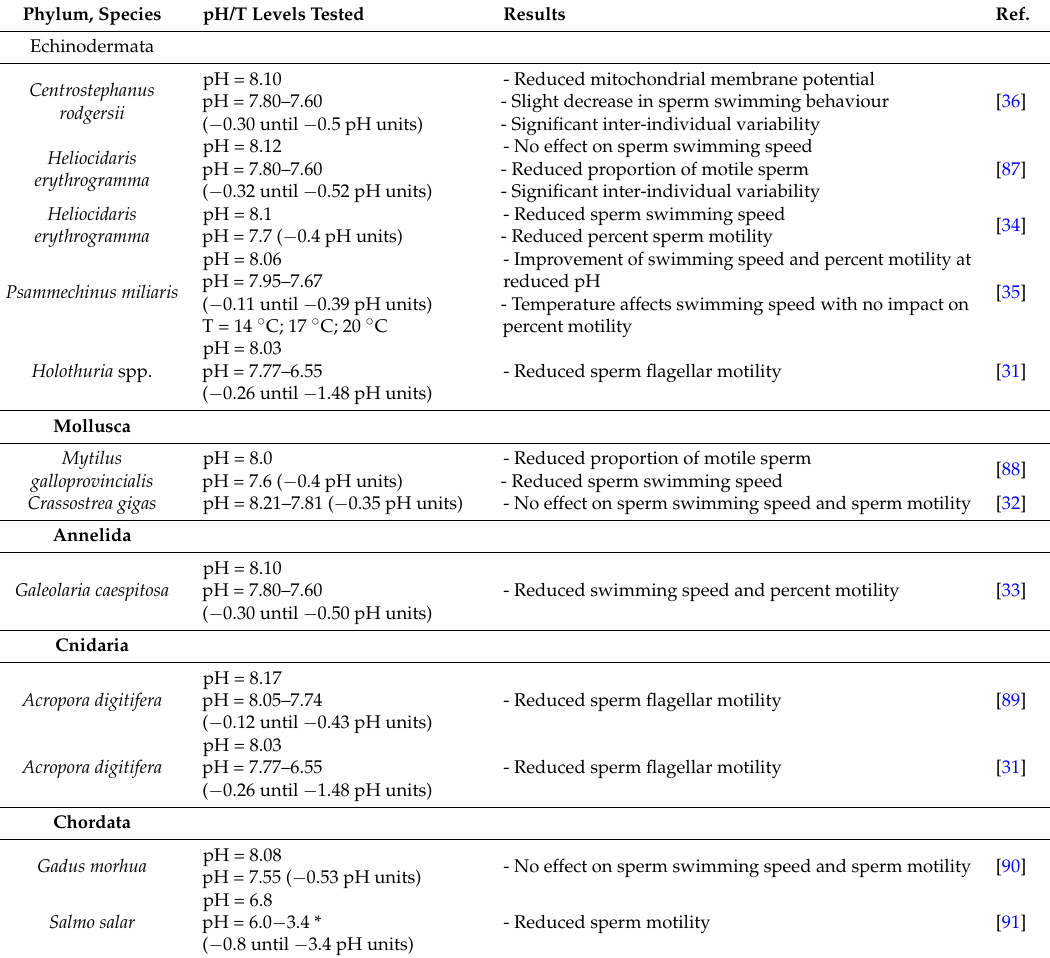
Table 2. Effects of pH/temperature changes on sperm cells